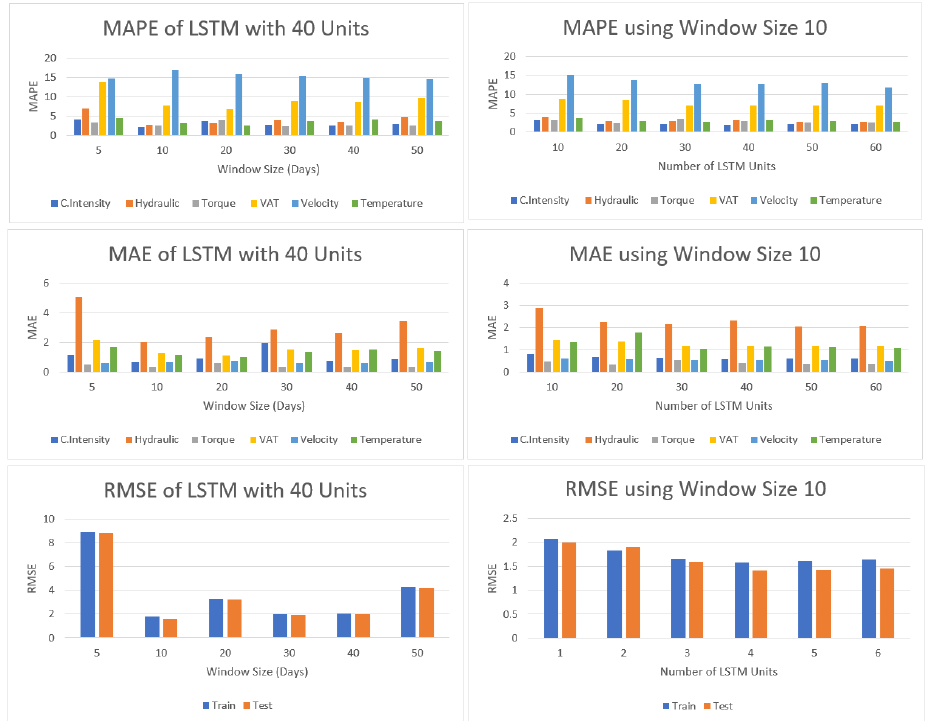
Figure 8. Results obtained with a different number of cells in the hidden layer, also using different window samples to predict values 30 days in advance with resampling for the two samples for a day.